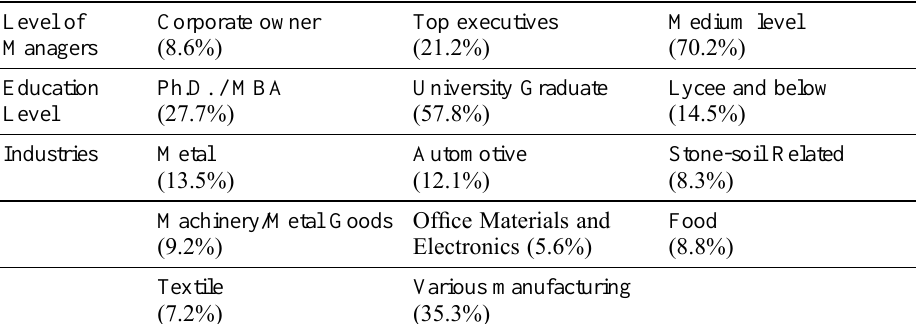
Table 1. Descriptive statistics of the